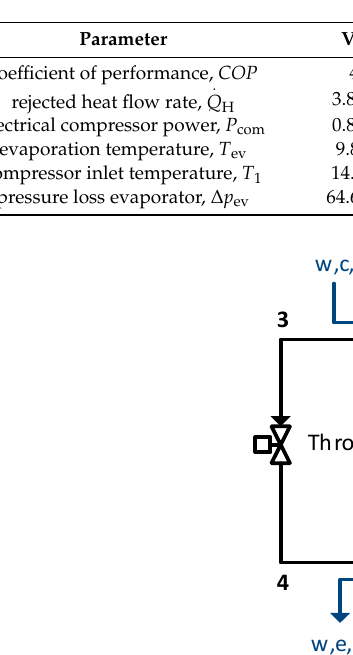
Table 1. Measured data of the reference fluid R134a.